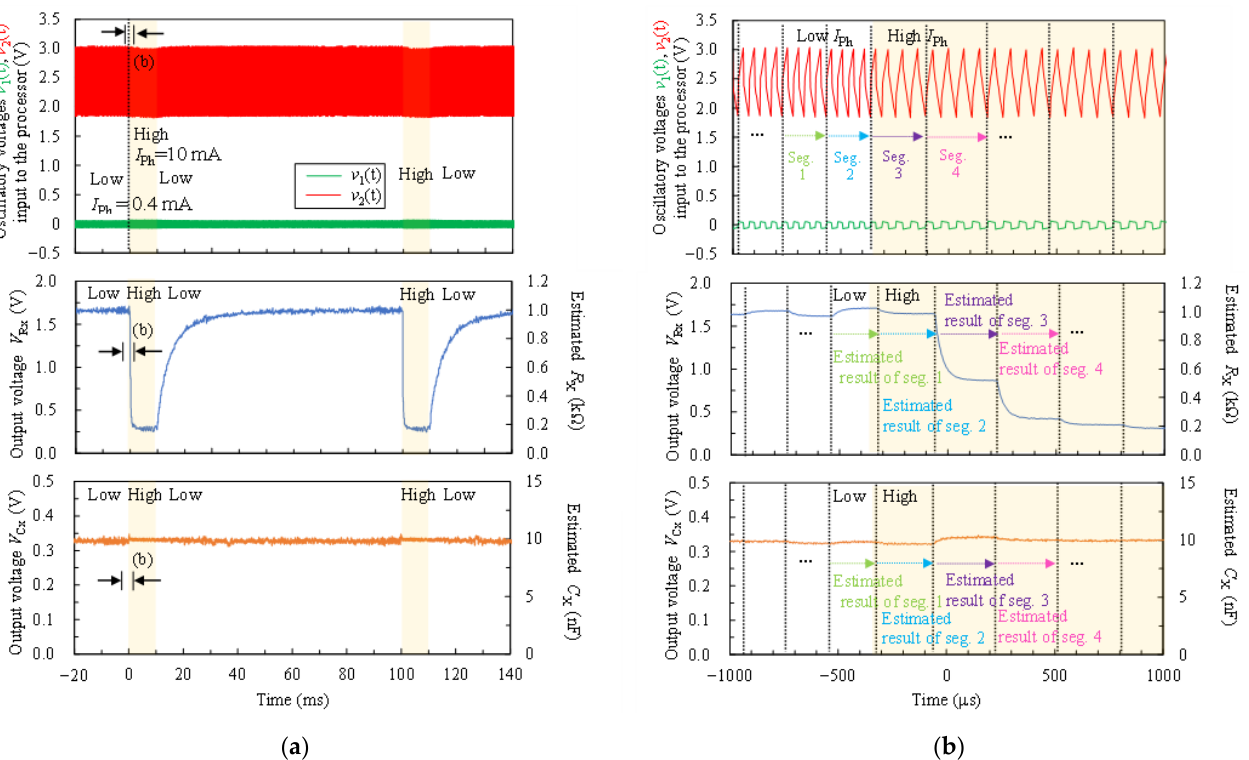
Figure 9. An example of the measurement result for a CdS photocell using the proposed FPGA-based processor when I Ph = 0.4 mA (Low), I Ph = 10 mA (High), M was set as 5th order, R max was set at 2.0 k Ω , and C max was set at 100 nF: ( a ) oscillatory voltage v 1 ( t ) and v 2 ( t ) input to the processor and resulting output voltages of V Rx and V Cx from the proposed FPGA-based processor. The top plot is the output of the nonsinusoidal oscillator circuit when connected to the measurement object through capacitive coupling and the input waveform of the proposed processor. v 1 ( t ) and v 2 ( t ) have nothing else to convert. The bottom two plots show the results of R x and C x circuit parameters estimated and converted to voltages for each segment (four cycles). These voltages were converted back into estimated values R x and C x , and are shown on the right side of the y-axis as the estimated values corresponding to the voltage; ( b ) enlarged view near 0 μ s ( − 1000 μ s to 1000 μ s) in Figure 9a.